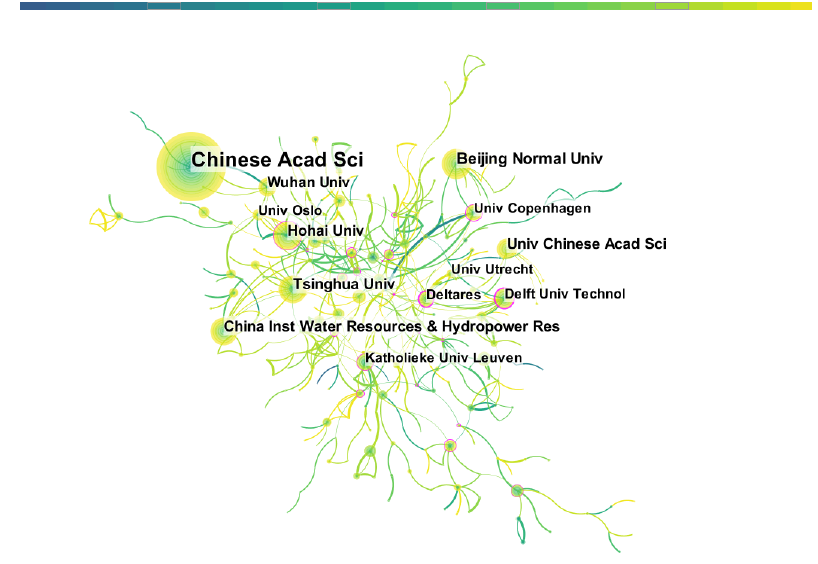
Figure 4. Institutional cooperation network map. Table 1. Top 10 research institutions in terms of publication volume.